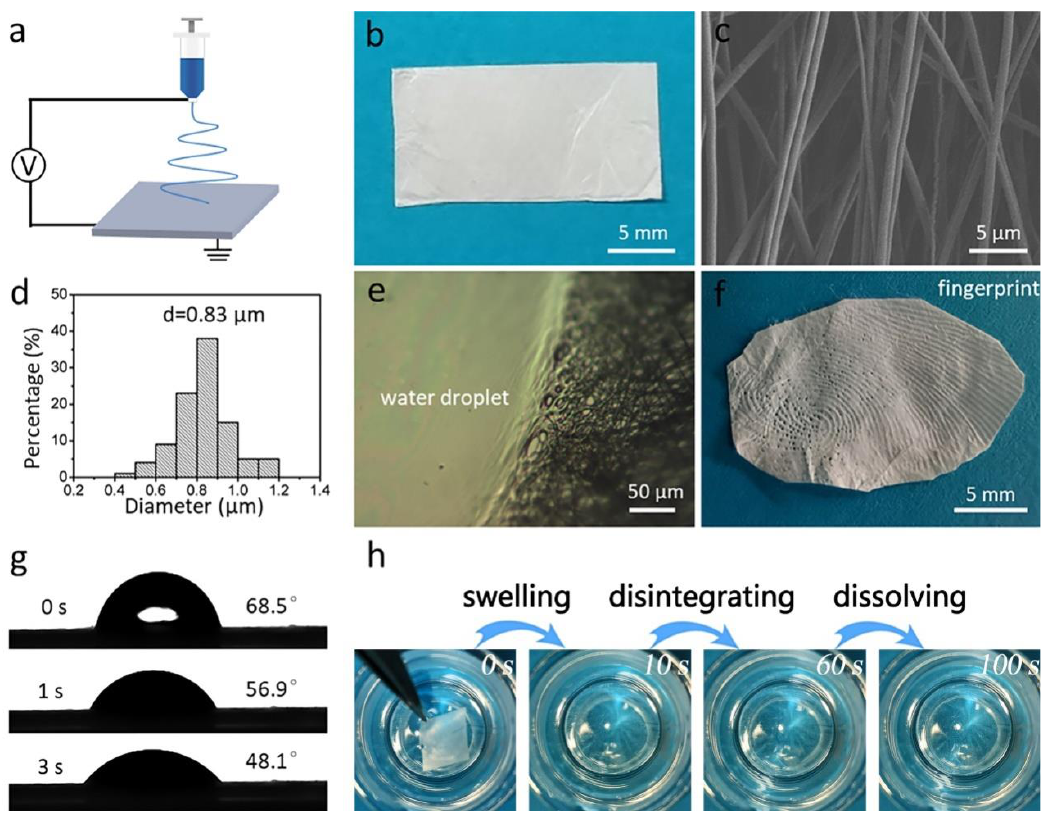
Figure 1. ( a ) Schematic illustration of the fabrication process of the electrospun nanofibrous gelatin membrane. ( b ) Optical image of the white gelatin membrane. ( c ) SEM image and ( d ) diameter distribution of the gelatin membrane. ( e ) Appearance of the membrane after contact with a water droplet. ( f ) A fingerprint that formed on the gelatin membrane. ( g ) WCA images of the gelatin membrane. ( h ) The fast dissolution process of the gelatin membrane.